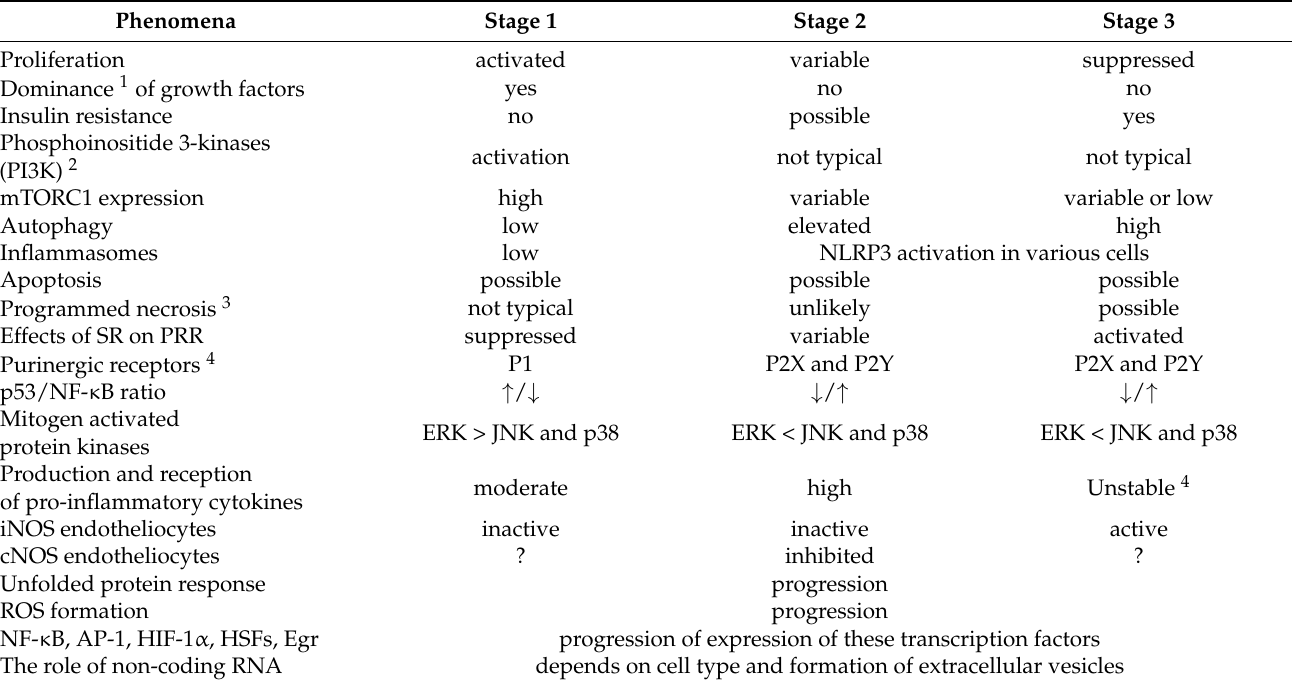
Table 1. Some phenomena of cellular stress characterizing possible stages of its